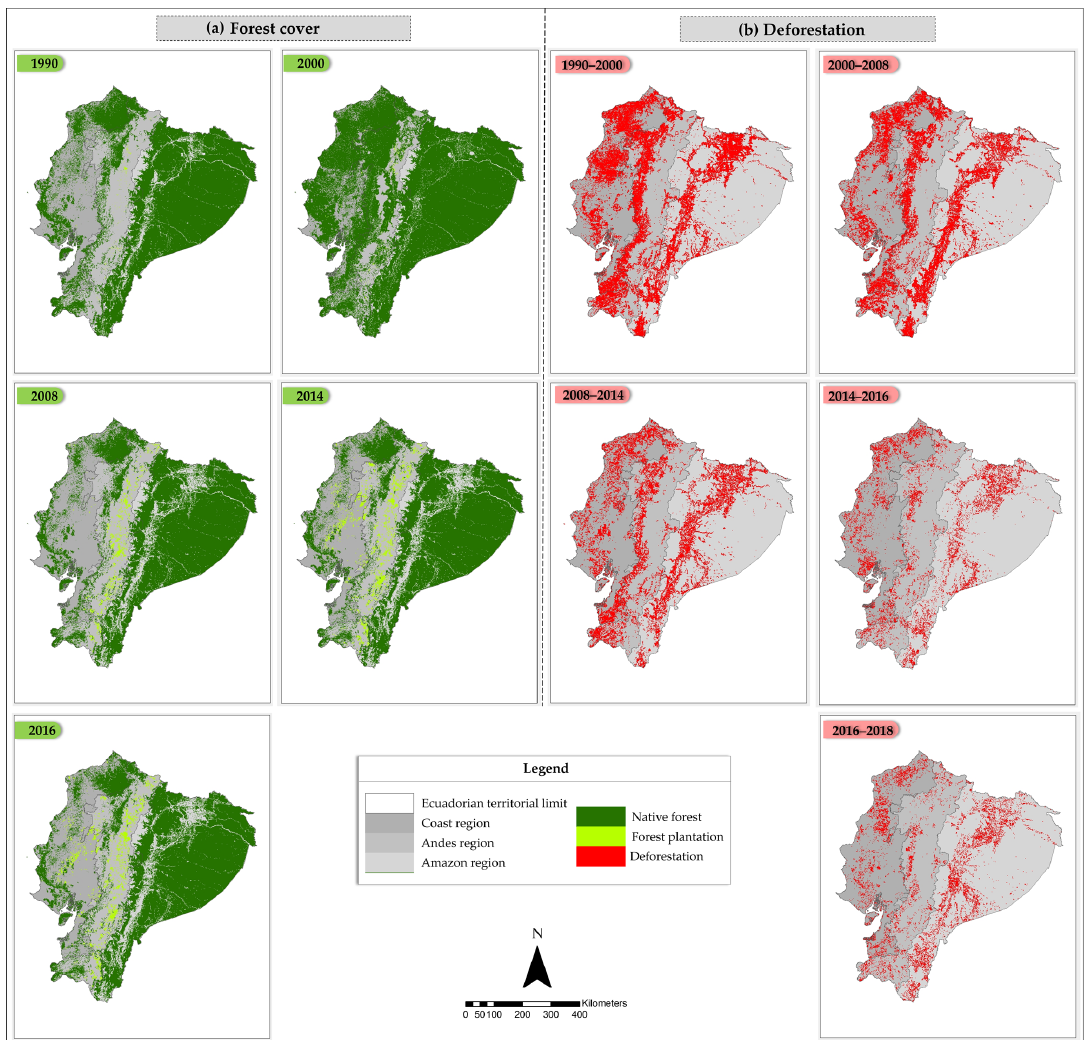
Figure 2. ( a ) Map of forest cover (native and planted) of Ecuador for the years 1990, 2000, 2008 (MAE) [48], 2014 MAE [49], and 2016 MAE [50]; ( b ) Deforestation map of Ecuador for the periods